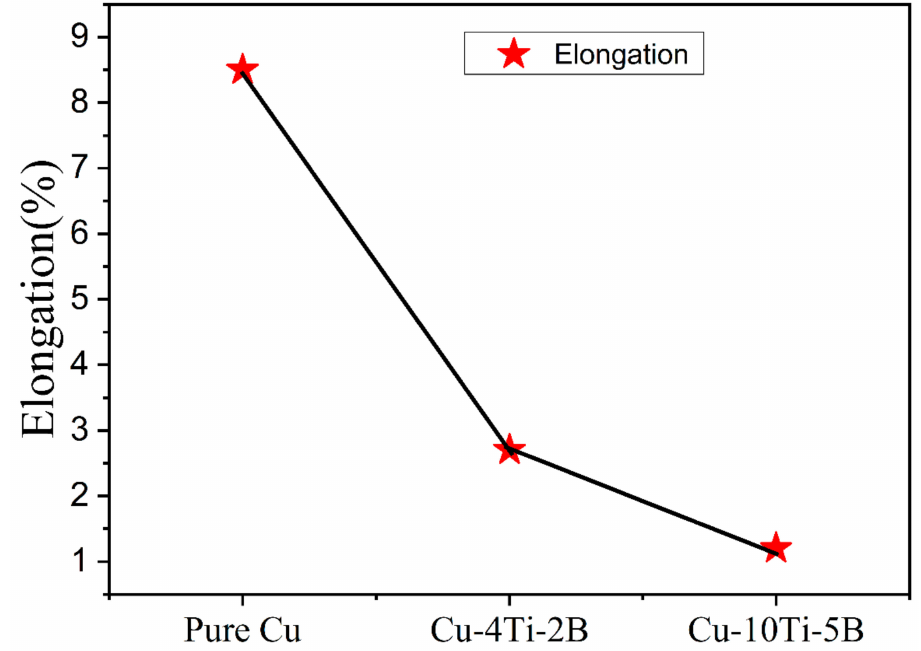
Figure 12. Elongation of pure Cu with two types of